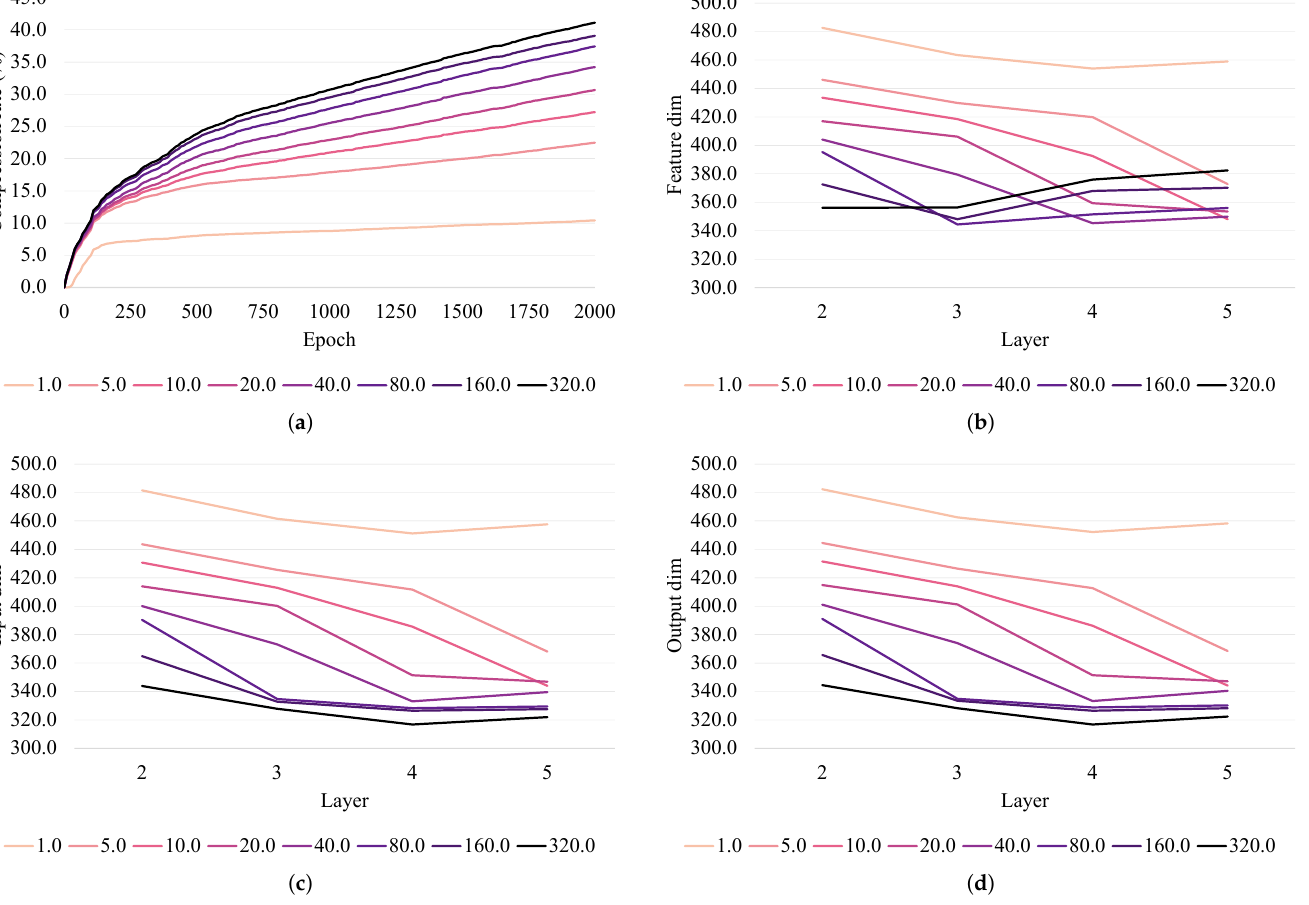
Figure 4. Characteristics of model compression with different values of λ 1 . ( a ) The compression rate of the proposed method over the course of training. ( b – d ) Feature space, input, and output dimension of each layer after training is